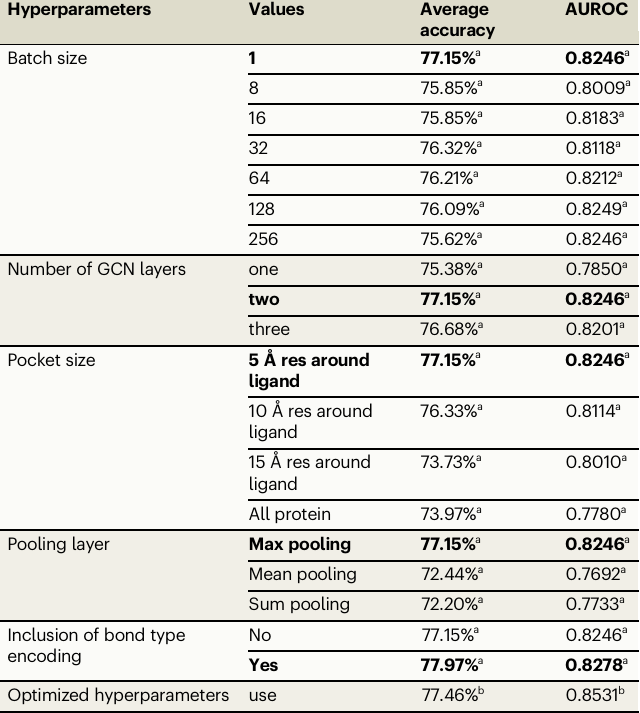
Table 2 | The optimization of DeepPROTACs model hyperparameters on validation set Hyperparameters